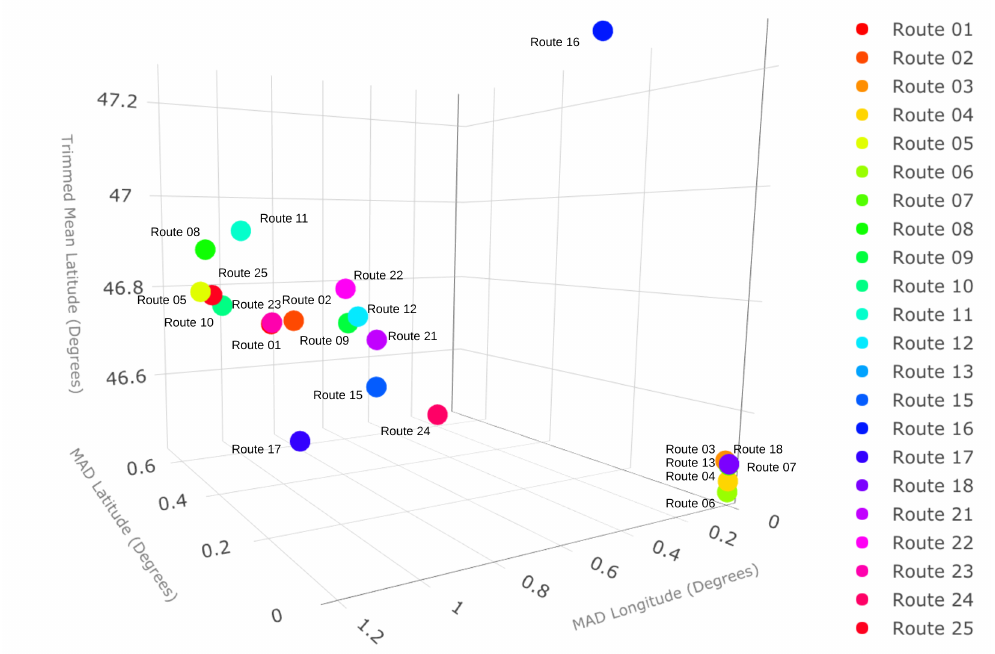
Figure 6. A three-dimensional perspective of three features of the routes, two of which are